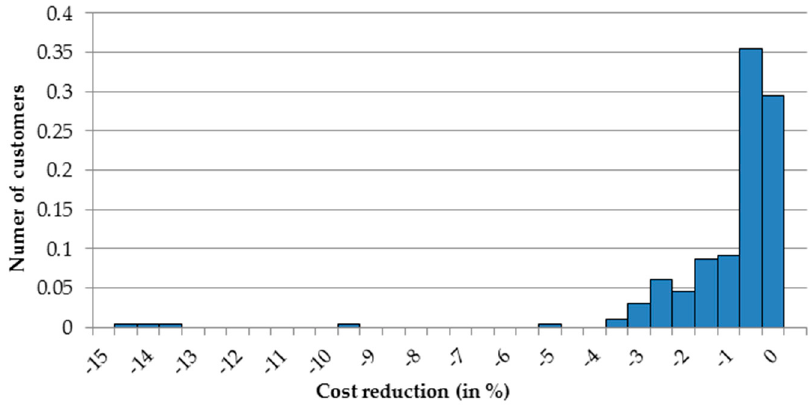
Figure 9. Distribution of cost reductions due to tariff switch.